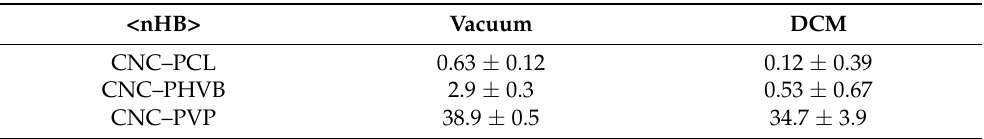
Table 11. Average number of hydrogen bonds formed by cellulose with the polymers in vacuum and in DCM at 298 K and 0.1